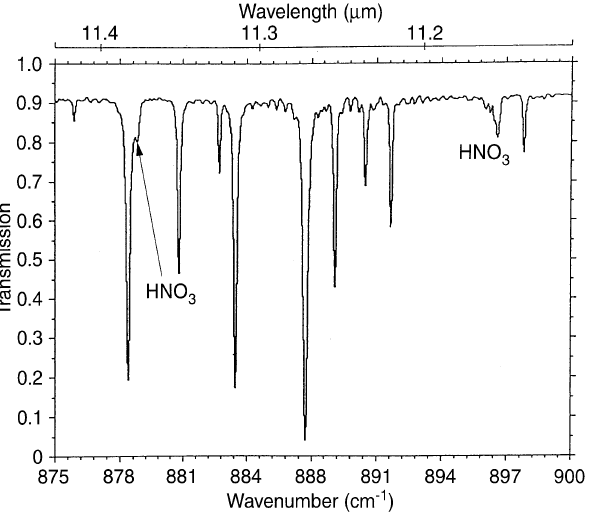
Fig. 9. Simulated ground-based atmospheric spectrum in the 875 — 900 cm (cid:126)(cid:49) spectral range, at solar zenith angle (SZA) " 76 ° ; the two Q branches at 879 cm (cid:126)(cid:49) and 896 cm (cid:126)(cid:49) of the nitric acid absorp- tion spectrum are visible